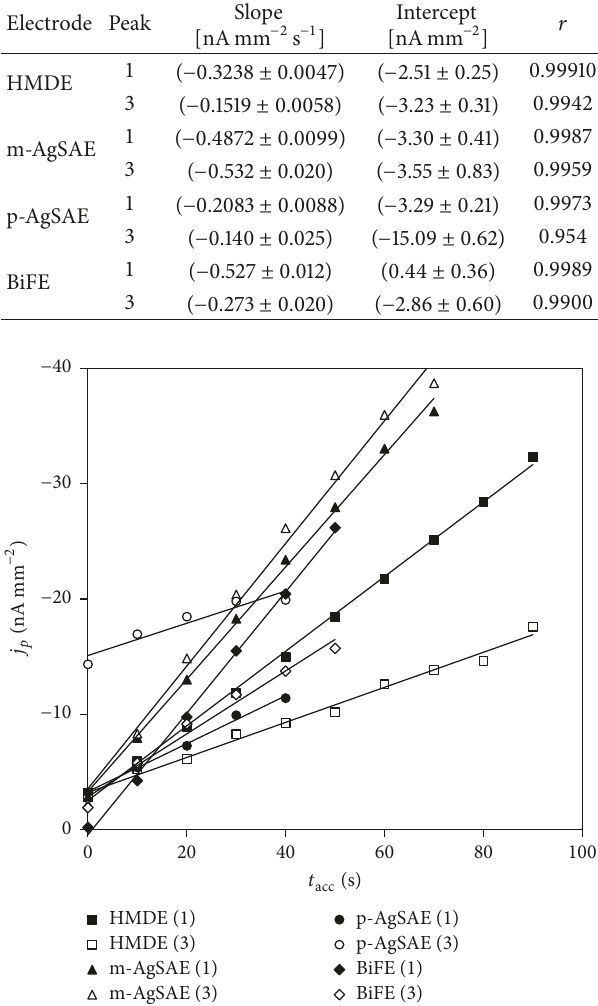
Figure 6: Dependence of 𝑗 𝑝 of DAN signals on 𝑡 obtained on all acc tested electrodes. Method: DPAdSV; electrolyte: BRB (pH 6.0 and 5.0 (BiFE)); 𝐸 in = +200 mV; 𝐸 fin = − 1100mV; V = 40 mVs −1 ; pulse height = − 60 mV and − 50mV (BiFE); pulse width = 40 ms and 60ms (BiFE); 𝐸 = +200 mV; 𝑡 = 0–90 s (HMDE), 0–70 s (m-AgSAE), acc acc 0–40 s (p-AgSAE), and 0–50 s (BiFE); 𝑐 = 2.0 × 10 −7 mol L −1 ; (1) DAN peak 1; (3) peak 3.